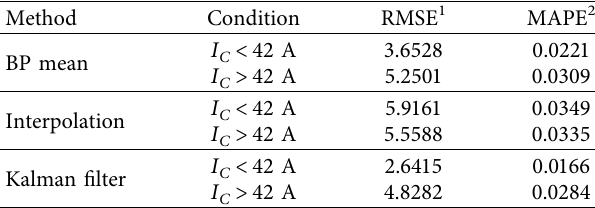
Table 3: The numerical comparison of three methods when I A. Test data